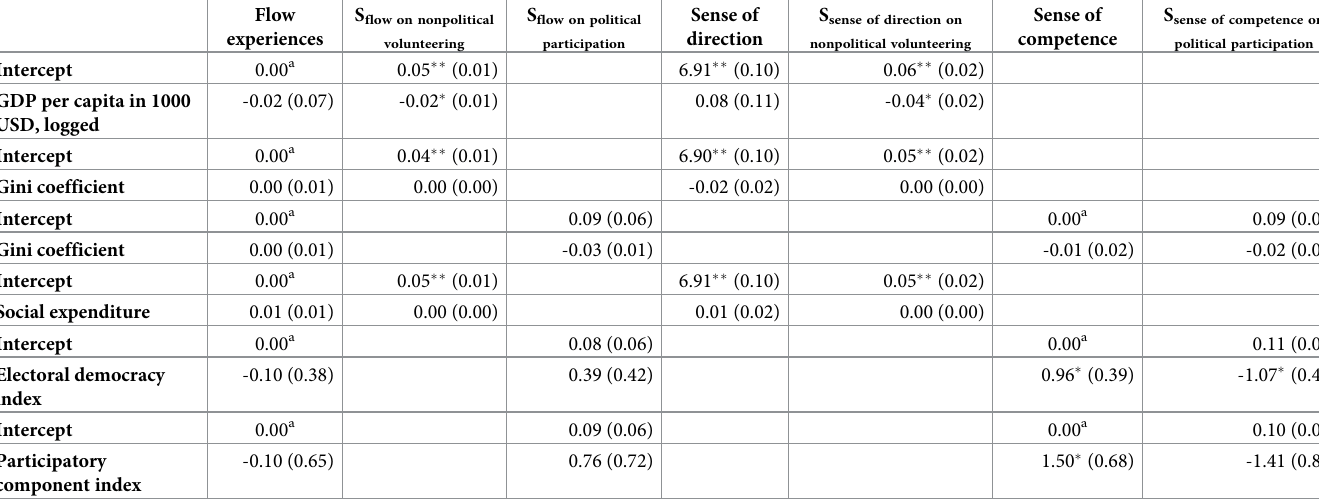
Table 7. Country-level effects of contextual variables on eudaimonic well-being and cross-level interactions with voluntary